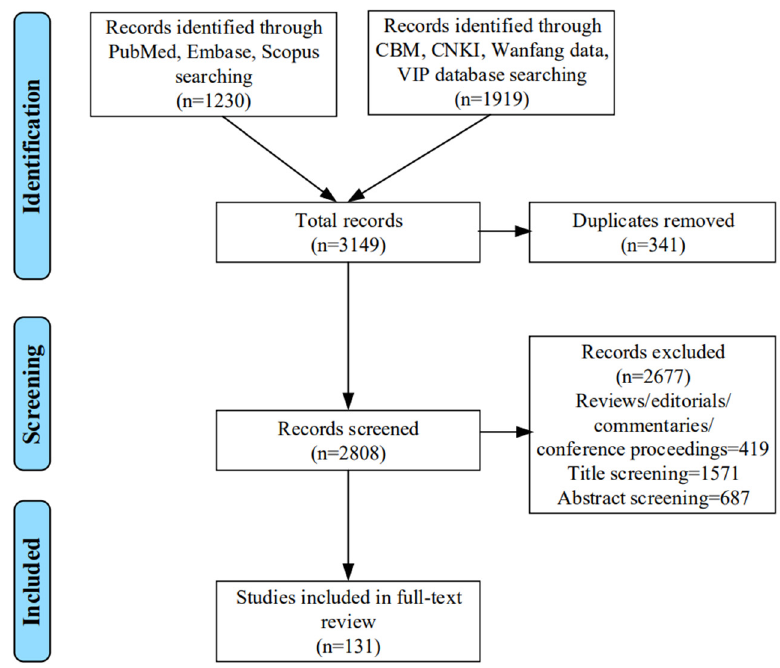
Figure 1. Flow chart of the selection process to retrieve all relevant studies.